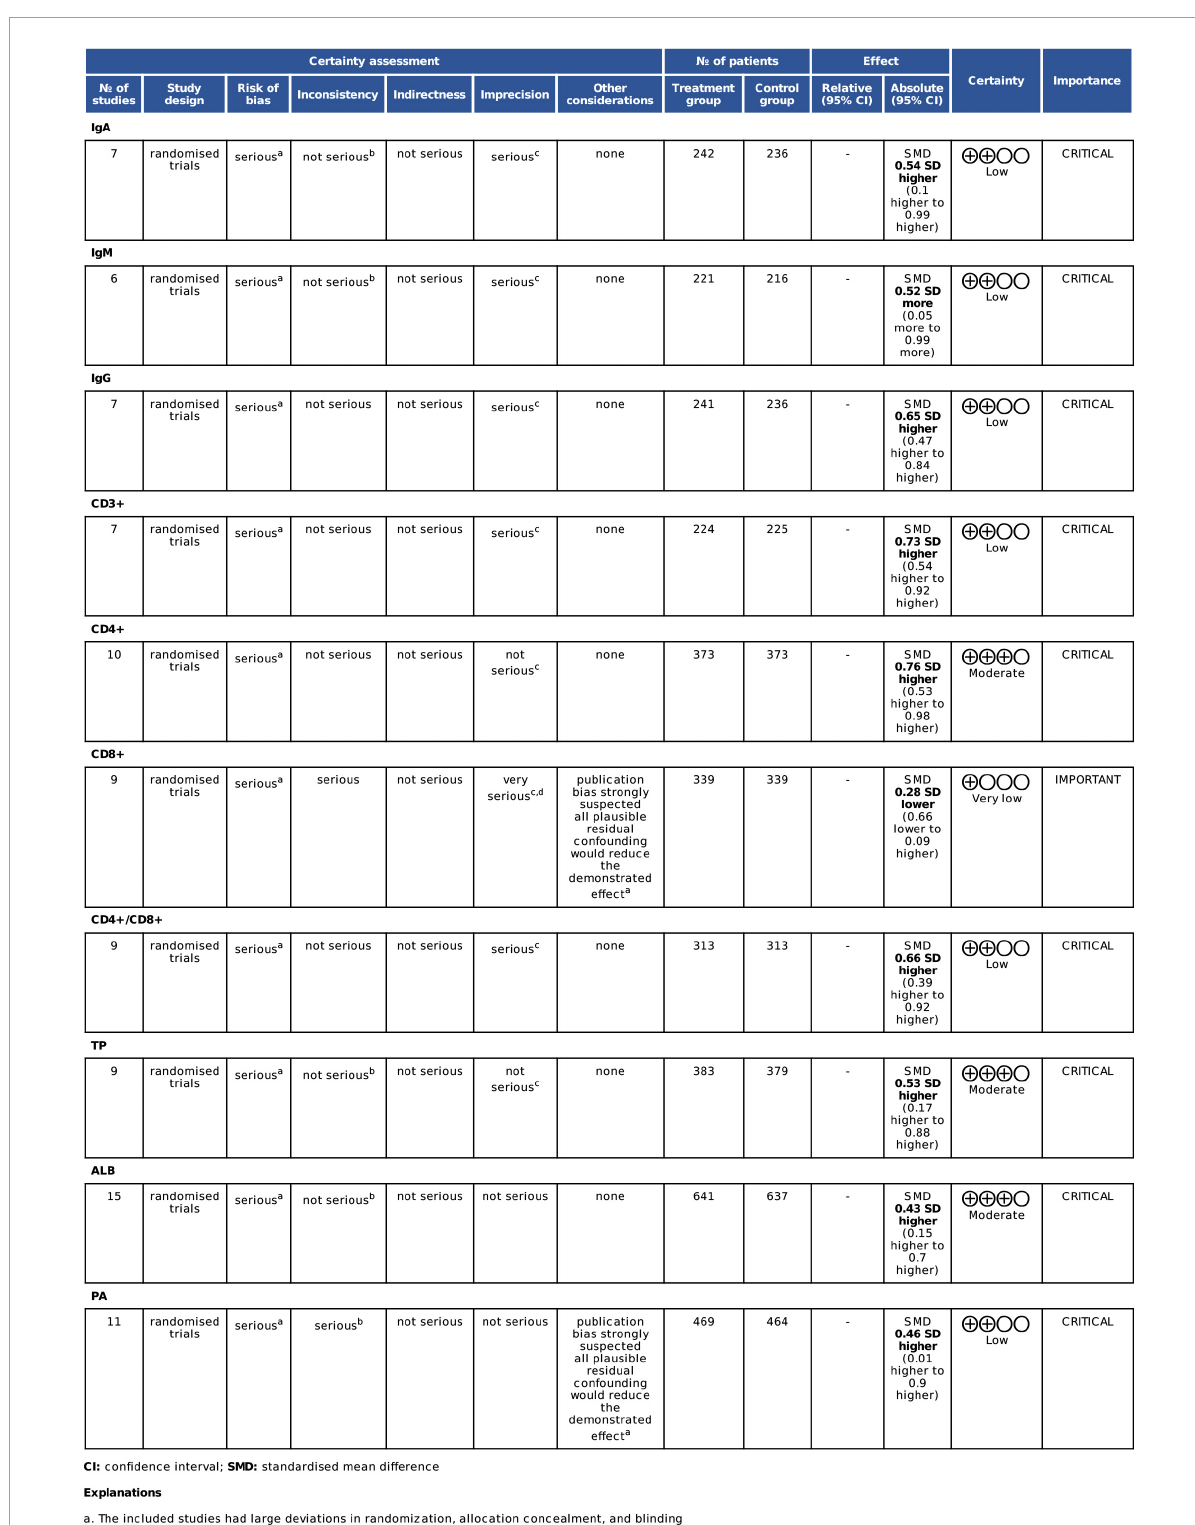
FIGURE3 GRADE evidence profile for all outcome measures. TP, total protein; ALB, albumin; PA, prealbumin.